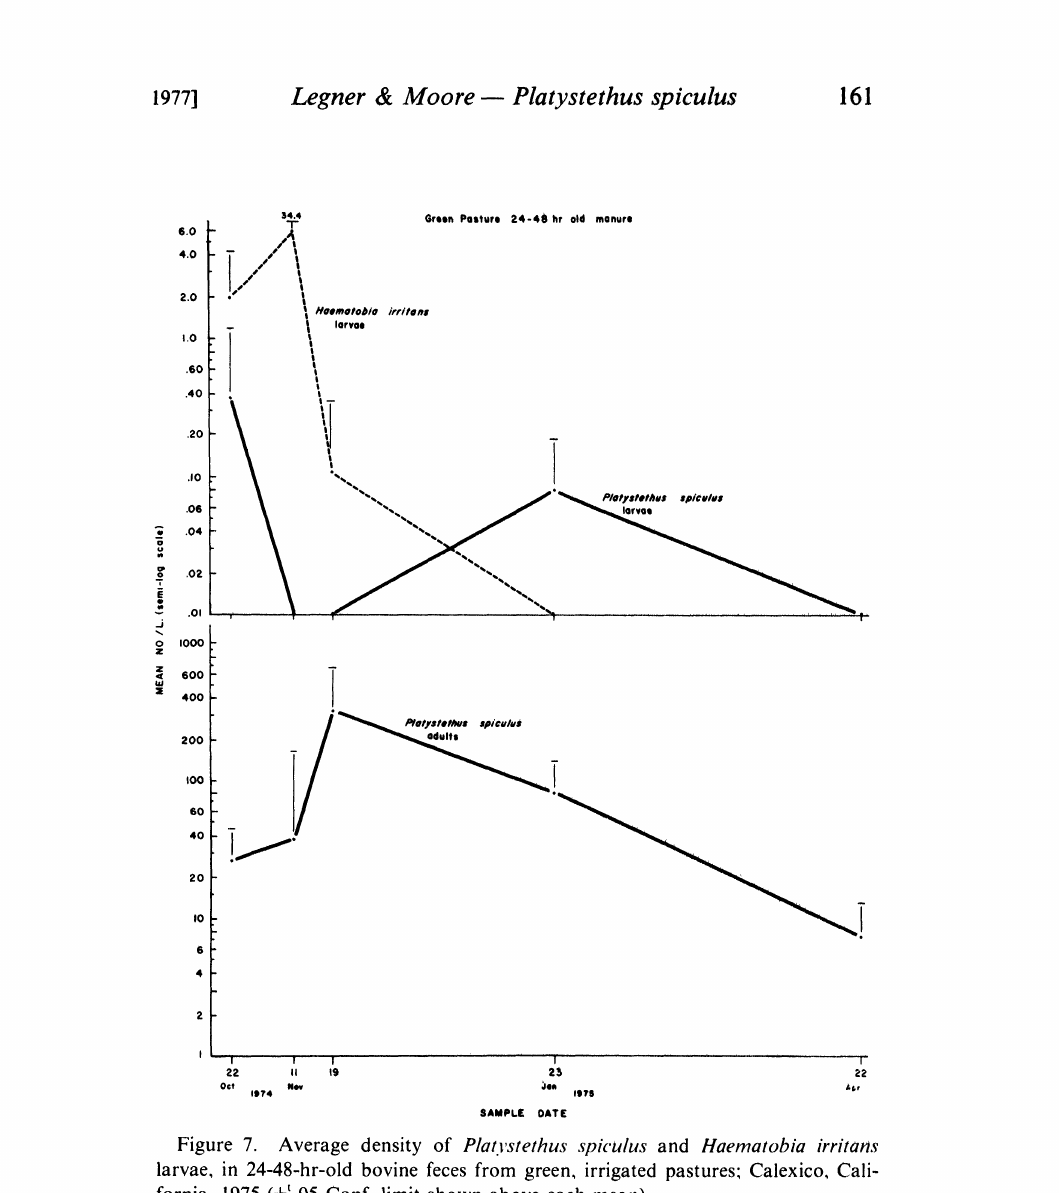
Figure 7. Average density of Platvstethus spiculus and Haematobia irritans larvae, in 24-48-hr-old bovine feces from green, irrigated pastures; Calexico, Cali- fornia, 1975 (+t 05 Conf. limit shown above each